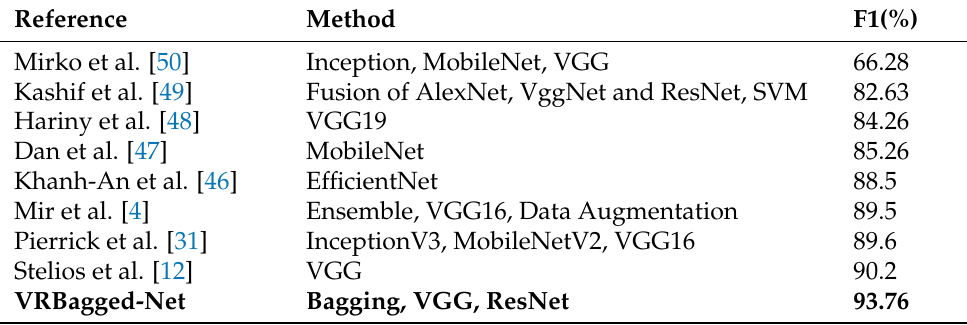
Table 4. INTD Dataset: Comparison of VRBagged-Net with state-of-the-art methods